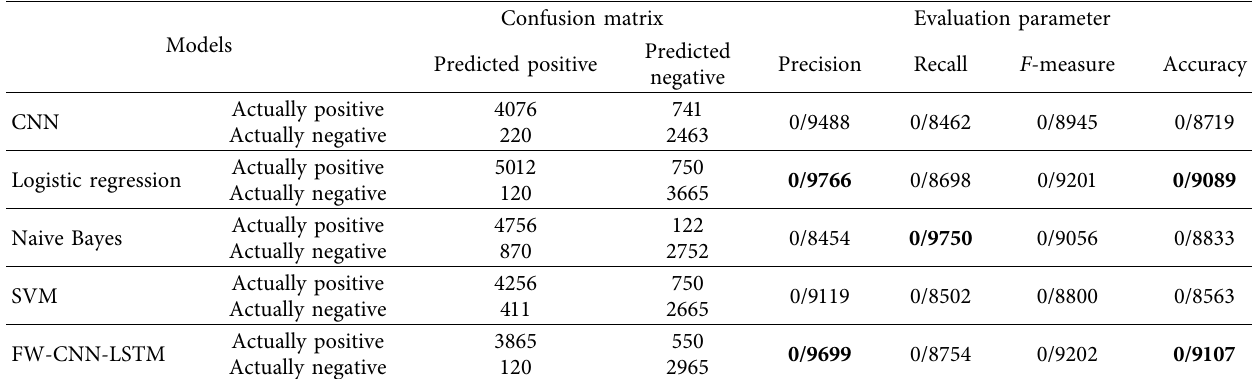
Table 7: Evaluation parameters for the IMDB